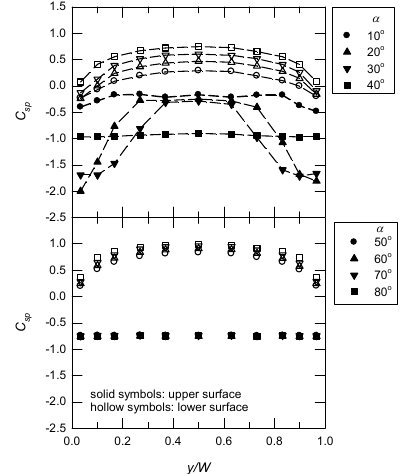
Figure 7. Mean spanwise pressure distributions at x/L = 0.5; β = 0°.